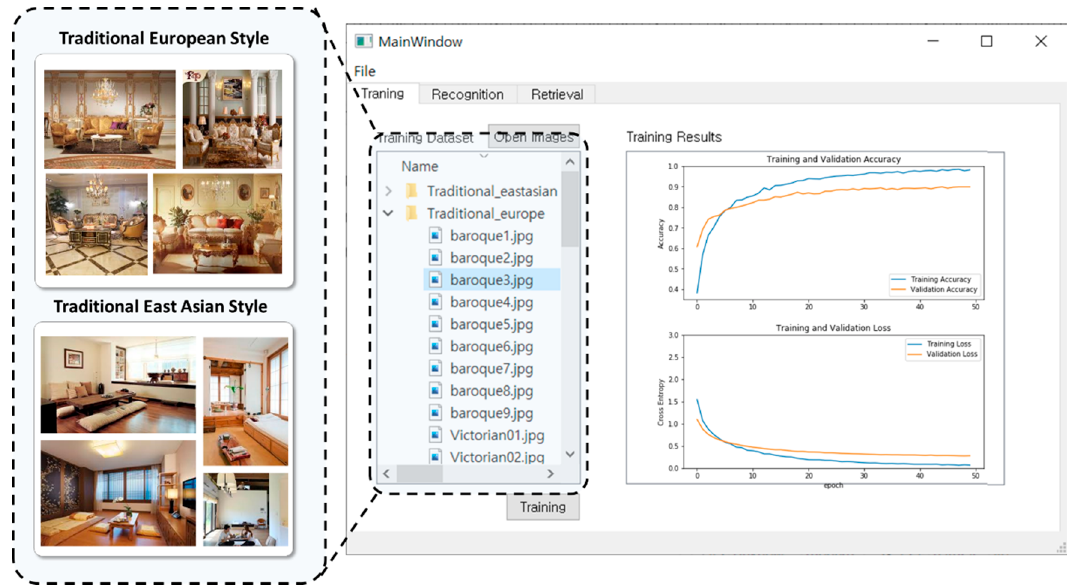
Figure 11. Examples of training an interior design style recognition model with a user-customized Figure 11. Examplesof trainingan interiordesign style recognition modelwith dataset.